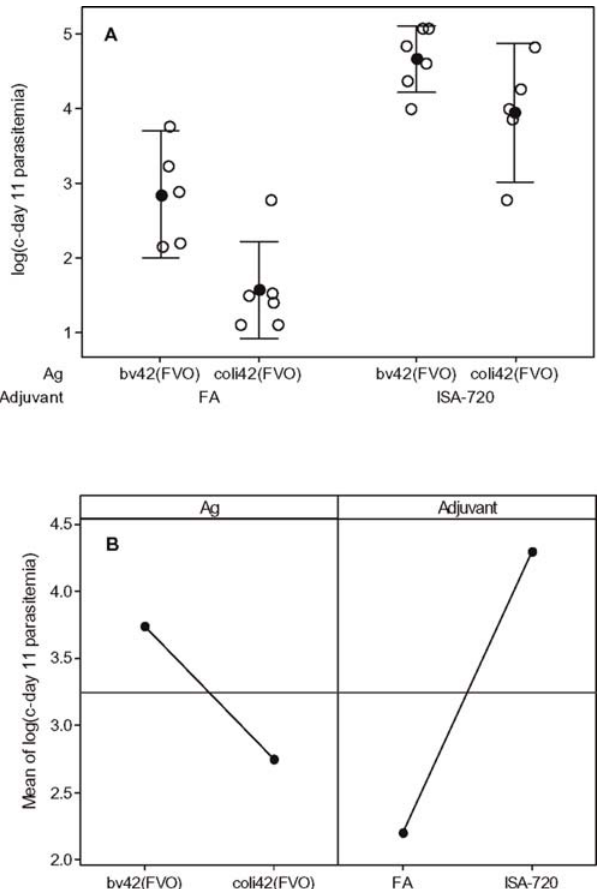
Figure 2. C-day 11 parasitemias for regimens 3, 7, 8, and 9 grouped by adjuvant and antigen. Open circles, individual responses; filled circles, means; bar is the 95% confidence interval for the mean. Panel A compares grouped log(c-day 11 parasitemia) levels. Panel B shows the estimated marginal means from the GLM used to analyze the